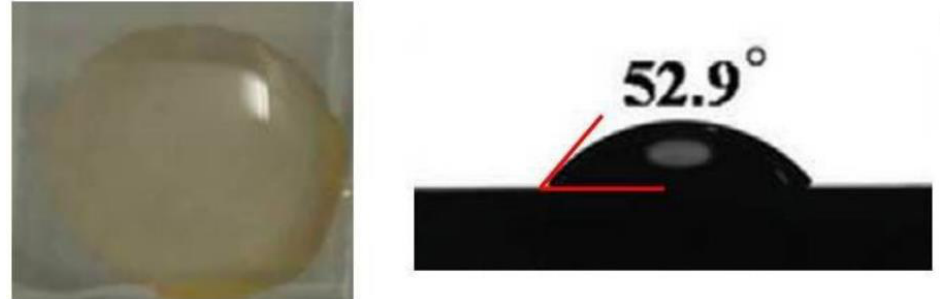
Figure 7. Photo and contact angles of pure PbBr 2 layer for CsBr/H 2 O solution [52] . Second, water can dissolve the perovskite and destroy the phase of CsPbBr 3 . Mean- while, the higher boiling point of water results in a slower volatilization rate compared to methanol, which is detrimental to the formation of high-quality CsPbBr 3 film with high- purity